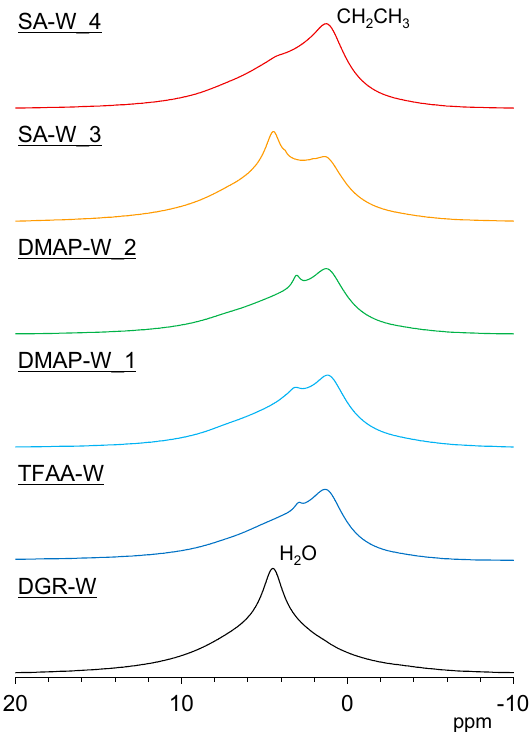
Figure 11. 1 H magic-angle spinning nuclear magnetic resonance (MAS NMR) spectra of degreased wood (black) and propionylated wood samples ( TFAA-W , blue; DMAP-W_1 , light blue; DMAP- W_2 , green; SA-W_3 , orange; and SA-W_4 , red).